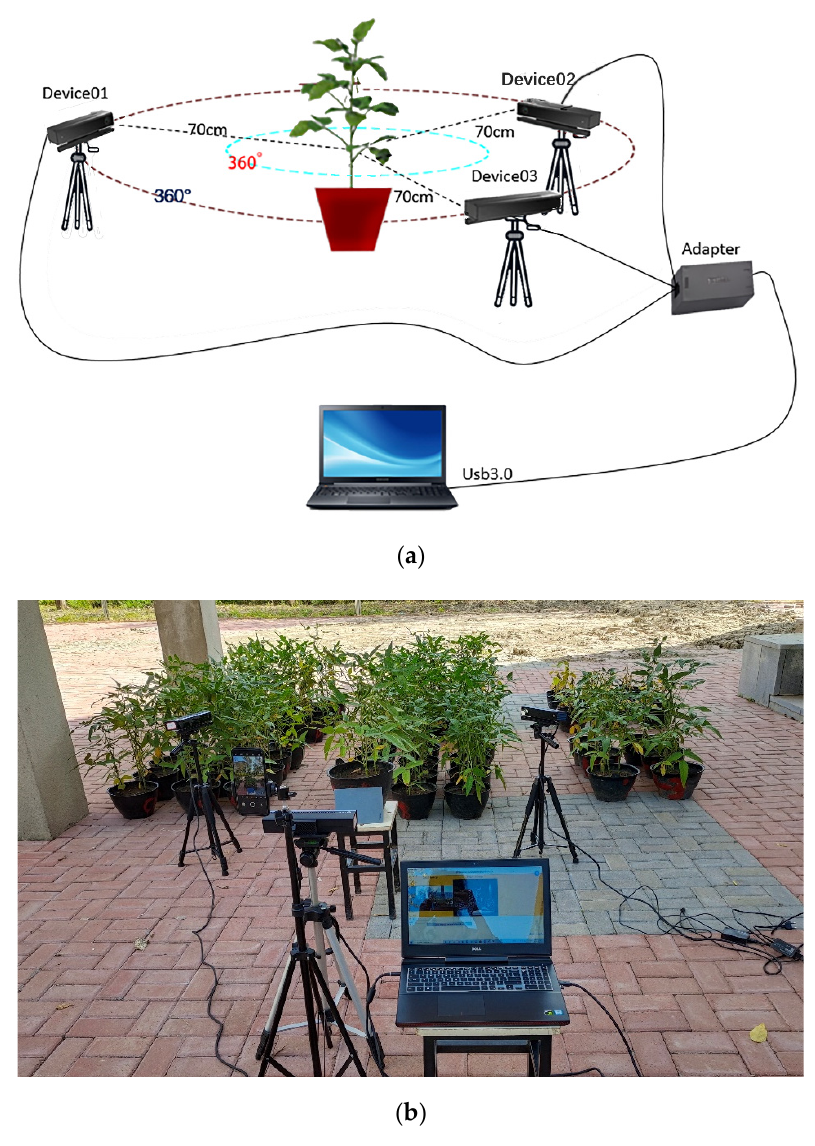
Figure 1. Schematic and scene of soybean canopy acquisition: ( a ) acquisition schematic; ( b ) experi- mental scene.